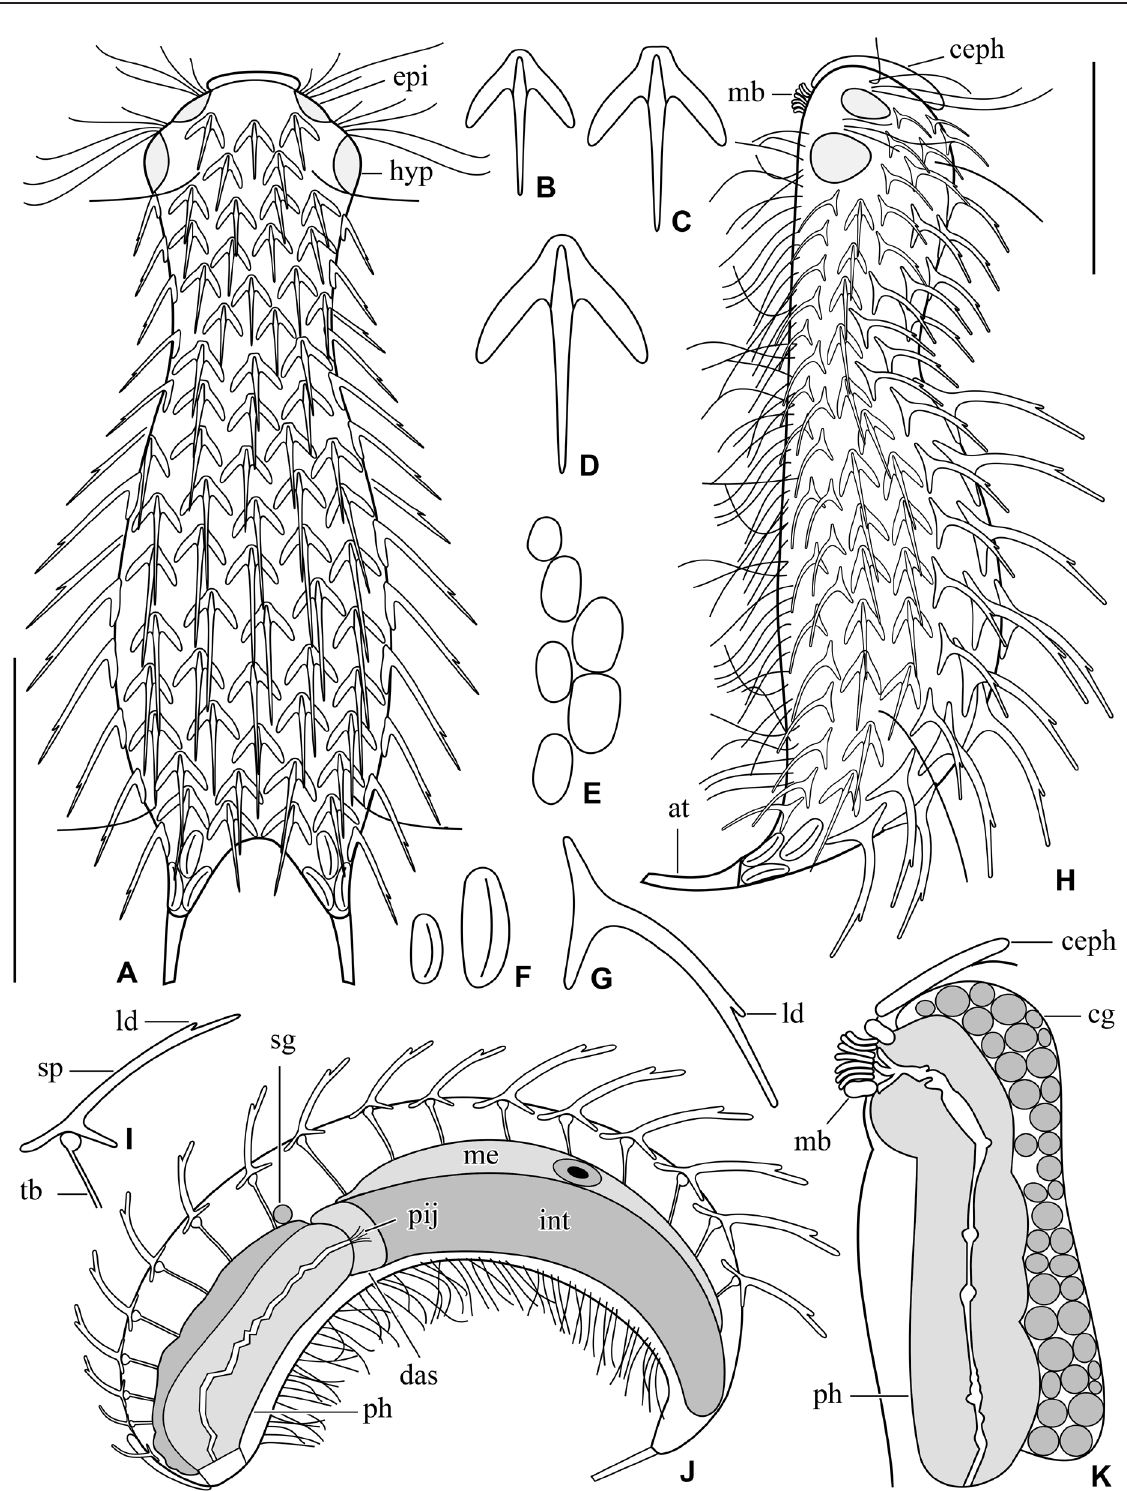
Fig. 15. Chaetonotus ( Hystricochaetonotus ) superbus sp. nov. A , H . Dorsal and lateral overviews showing the scale and spine pattern. B . Head scale. C . Neck scale. D . Trunk scale. E . Ventral scales. F . Upper- furcal dorsal scales. G . Lateral view of a trunk spined scale. I . Lateral view showing the connection of a transversal band to the base of a scale. J . Lateral overview showing the internal morphology. K . Lateral view of the anterior body region. Scale bars = 30